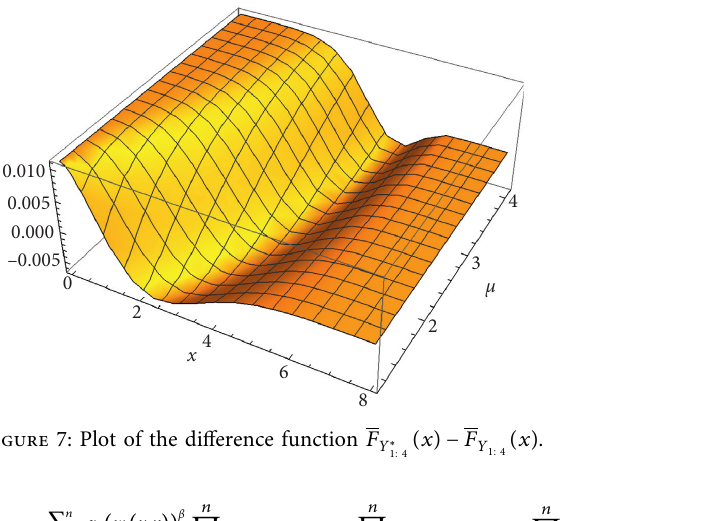
( x ) − F ( x ) Y ∗ 1 : 4 Y 1 : 4